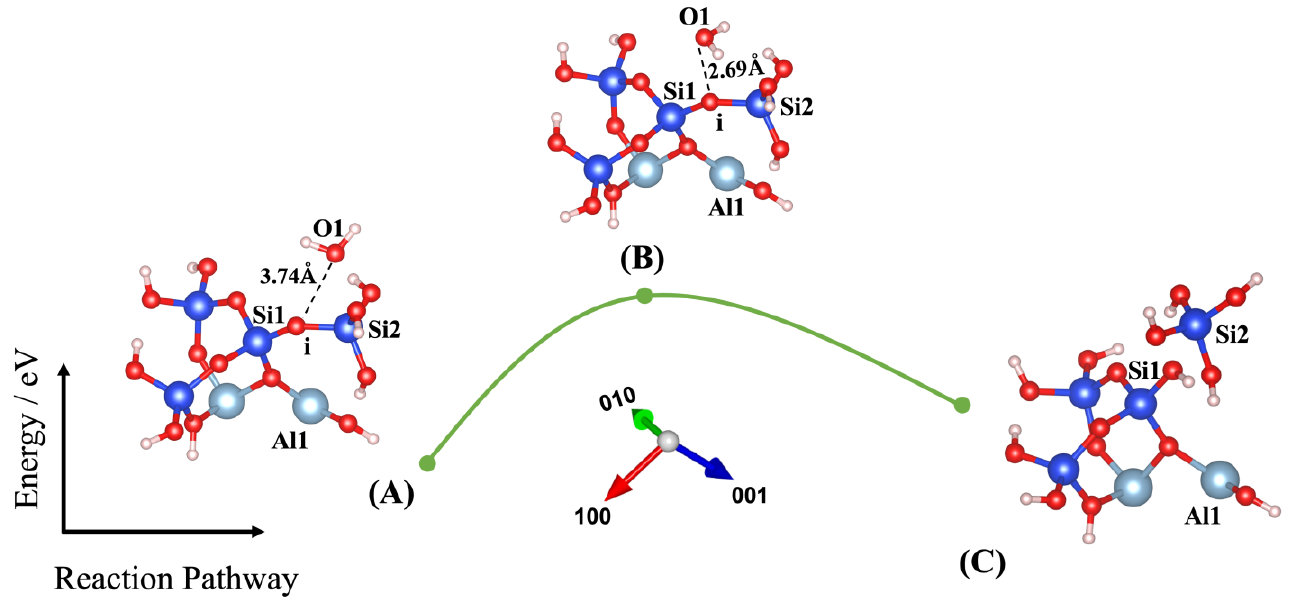
Figure 5. Model 3: ( A ) Ground state obtained as an optimized geometric structure of reactant, including water molecule as absorbent on MK surface (00 1̅ ) obtained from model 2(C) for breaking the bridging oxygen, bonded to the aluminum neighbor (Al1). ( B ) TS at the saddle point using improved dimer method. ( C ) Ground state obtained as an optimized geometric structure of product after protonation of the bridging oxygen, bonded to the aluminum neighbor. The structural building units are described in caption of Figure 2. E _reactant, E _transition state, and E _product have been collected in Table 1.